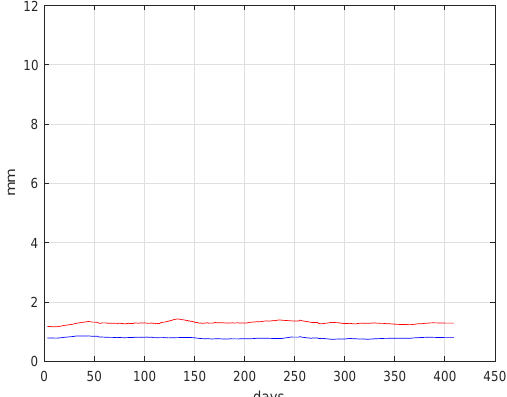
Figure 22. 3D formal error standard deviations for the East point (red line) and the West point (blue